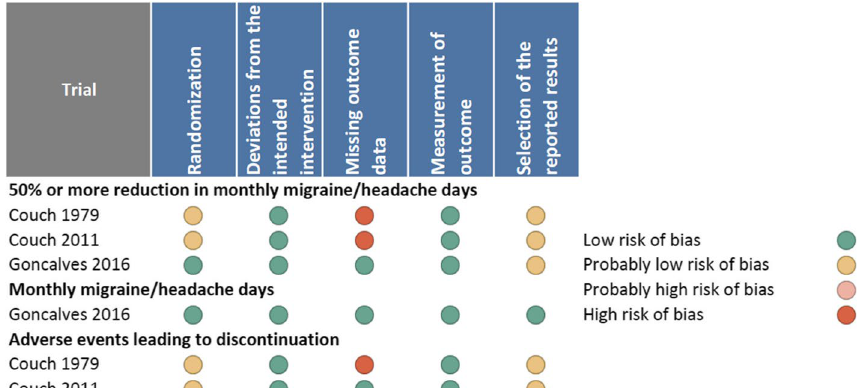
Fig. 3 Risk of bias ratings. Two out of three trials and one out of two trials were at high risk of bias due to missing outcome data for 50% or more reduction in monthly migraine days and adverse events leading to discontinuation, respectively. One trial, reporting on monthly migraine days, was at low risk of bias